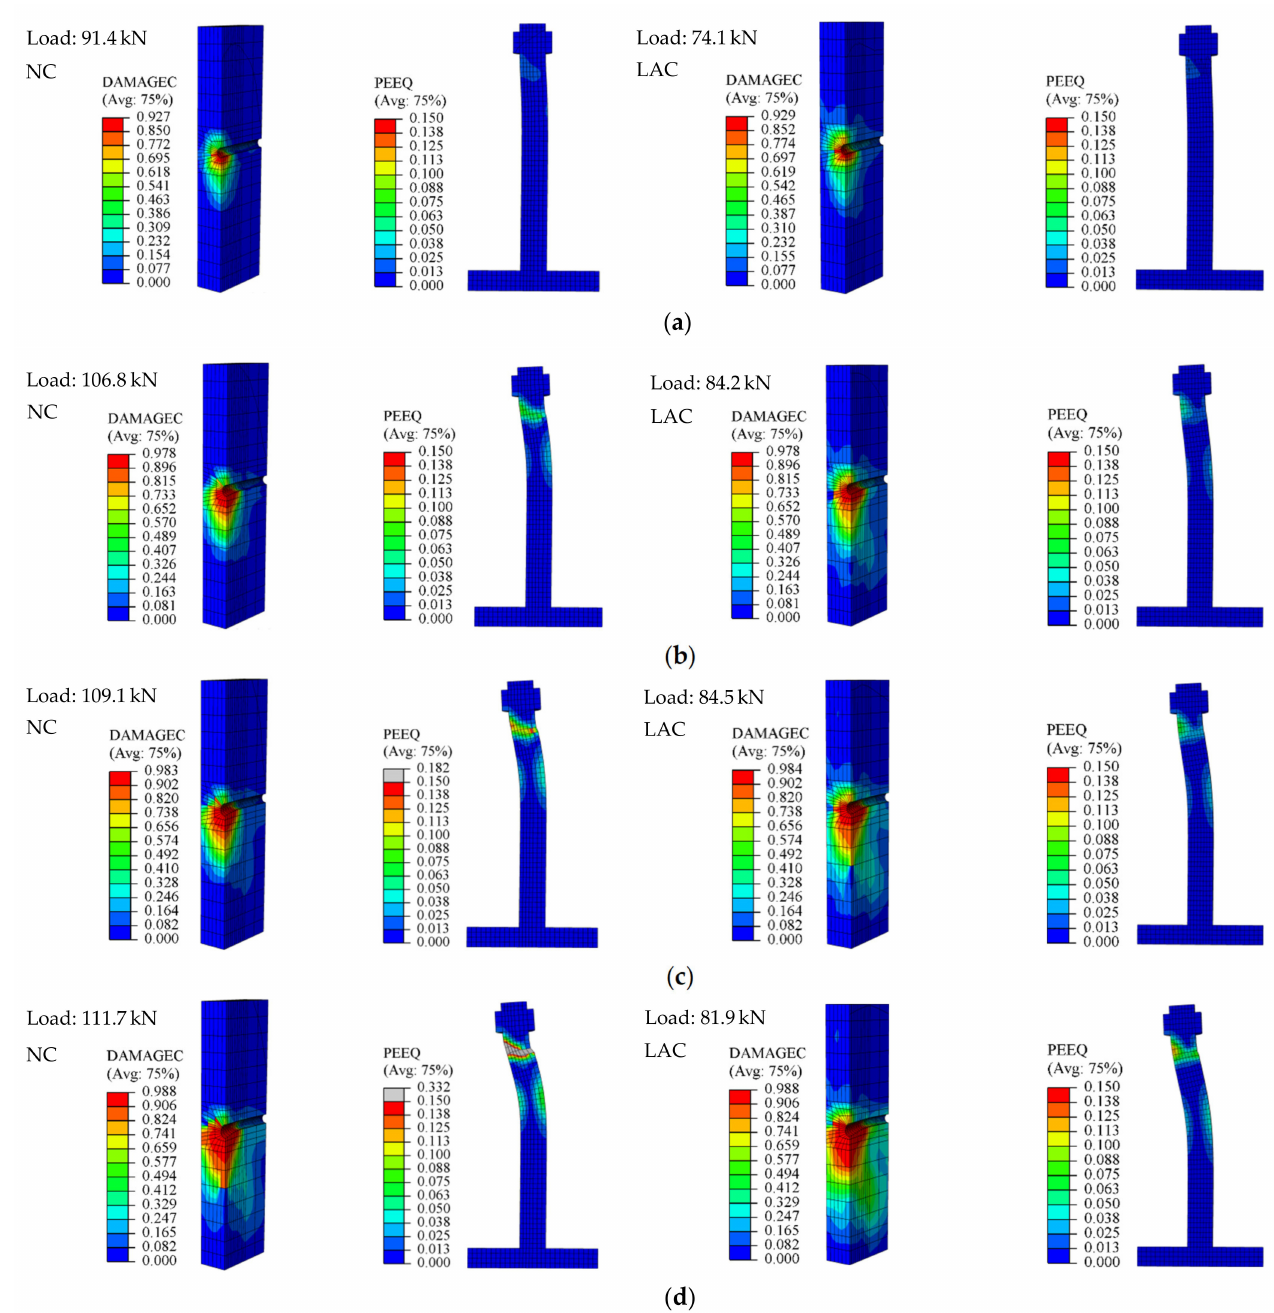
Figure 13. Comparison of failure modes between FE-NC and FE-LAC (M16-C30, M16-LC30): ( a ) s = 2 mm; ( b ) s = 6 mm; ( c ) s = 8 mm; ( d ) s = 12